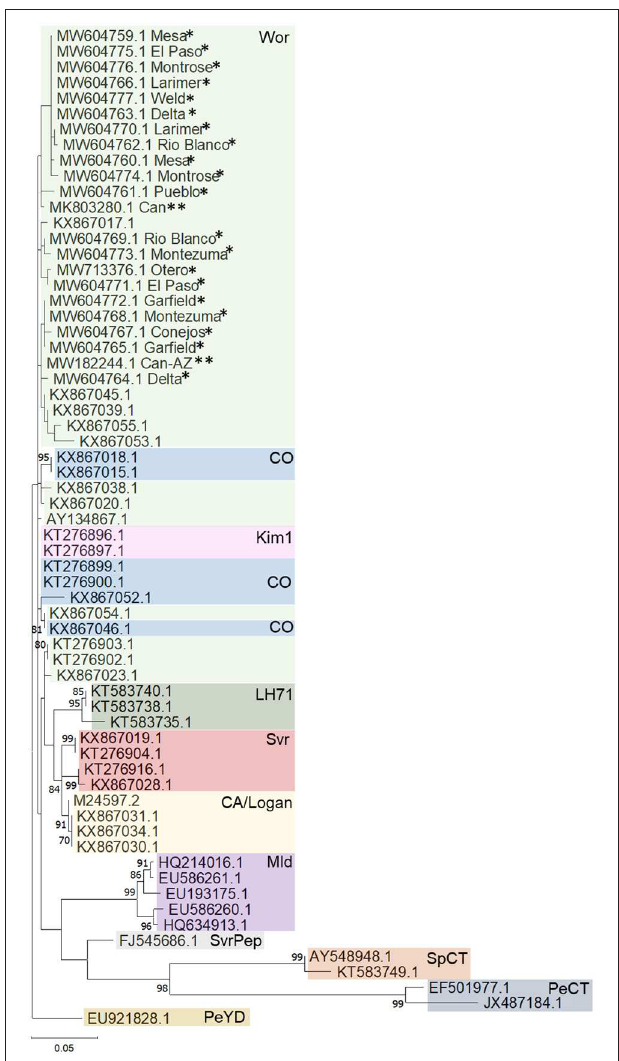
FIGURE 2 | Phylogenetic analysis of partial coat protein sequences of beet curly top virus (BCTV) obtained from hemp samples collected during the 2019 field season in Colorado and other BCTV sequences available in GenBank. Phylogenetic analysis by Maximum Likelihood method was done using MUSCLE in MEGAX. Single asterisks indicate genotypes from Colorado from this study, double asterisk indicate accessions from previously published BCTV-Cannabis genotypes. Bootstrap values are indicated on the nodes. Bootstrap values < 70% out of 1,000 replicates are not shown. Scale bar indicates number of substitutions per site. CA/Logan, BCTV strains California/Logan; CO, Colorado; Kim1, Kimberly 1; Mld, Mild; LH71, Leafhopper 71; PeCT, Pepper curly top; PeYD, Pepper yellow dwarf; Svr, Severe; SvrPep, Severe pepper; SpCT, Spinach curly top; Wor, Worland.